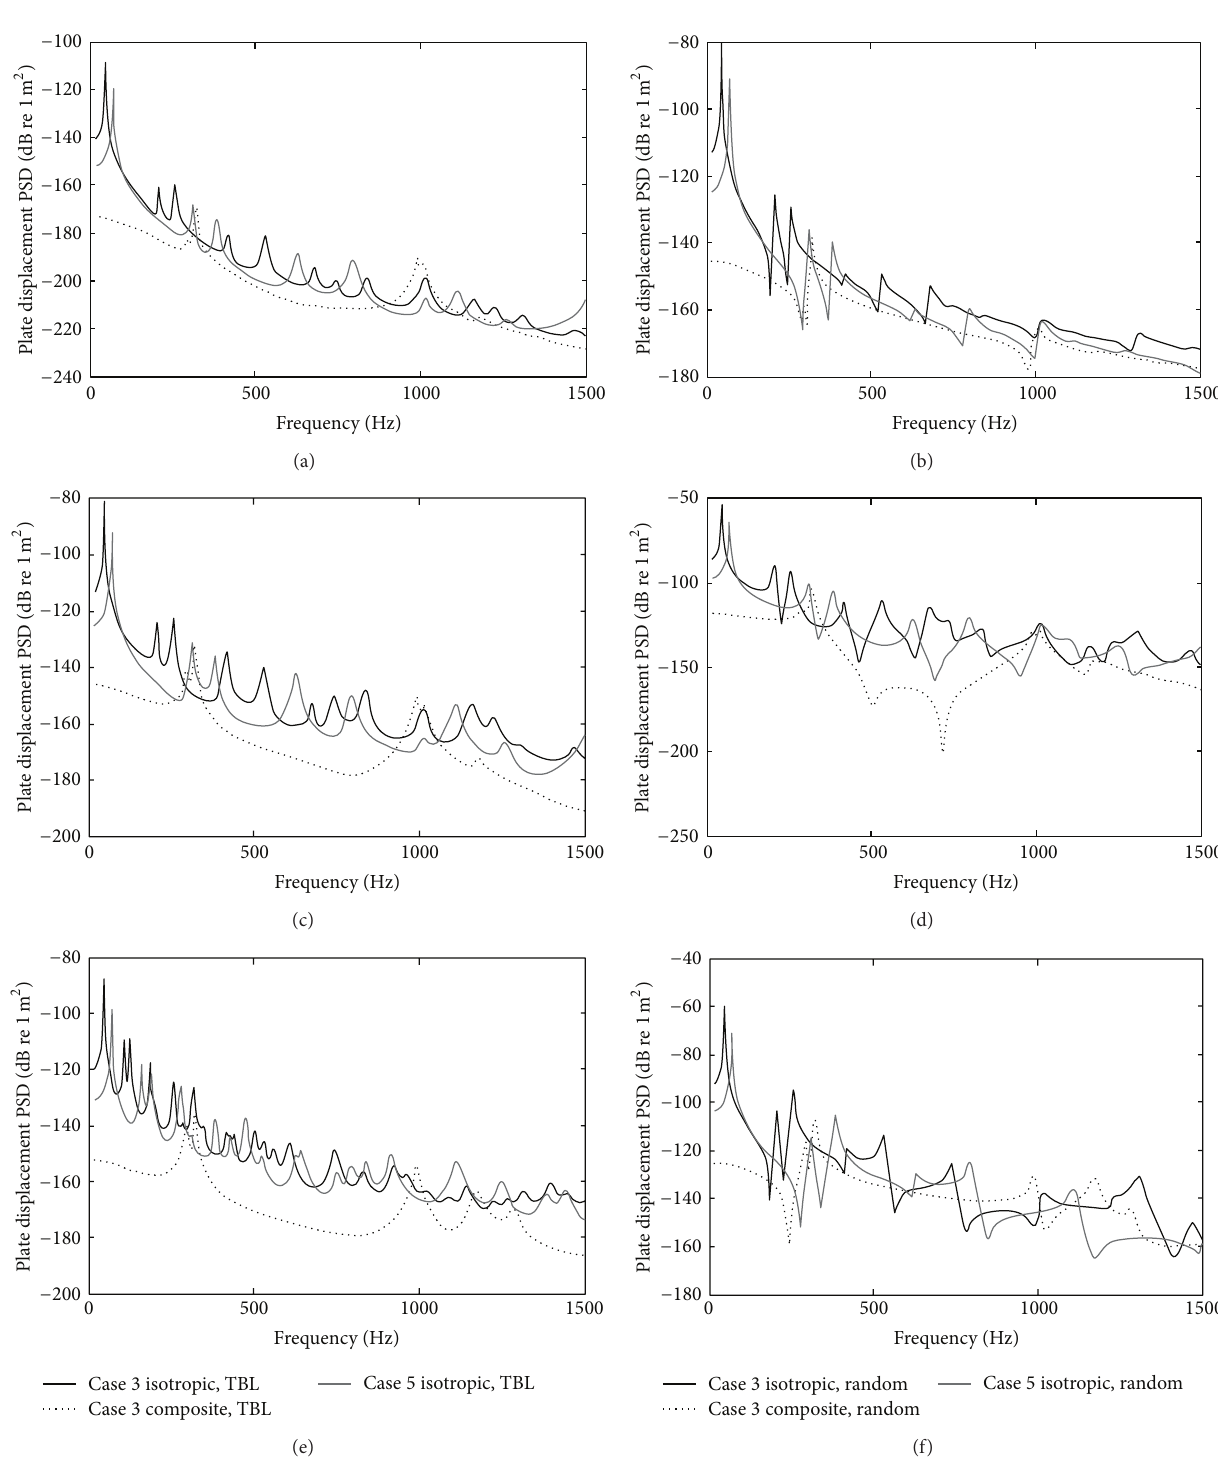
Figure 9: Comparison of panel displacement PSD results, for Case 3 composite panel versus Cases 3 and 5 isotropic panels: (a) and (b) overall panel 𝑆 𝑤𝑤 ; (c) and (d) 𝑆 𝑤𝑤 near surface location (𝑥 1 , 𝑦 1 ) = (0.5𝑎, 0.5𝑏) ; (e) and (f) 𝑆 𝑤𝑤 near location (𝑥 2 ,𝑦 2 ) = (0.3𝑎, 0.2𝑏)